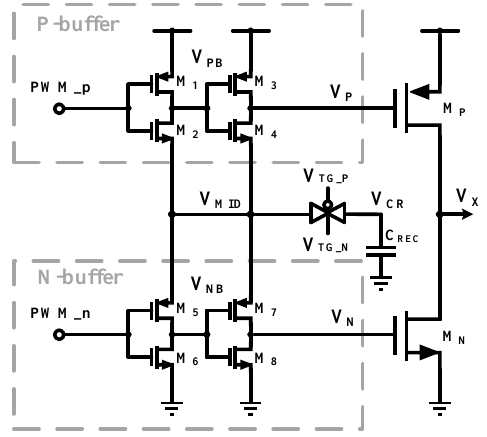
Figure 2. Proposed charge-recycling variable-swing gate driver.